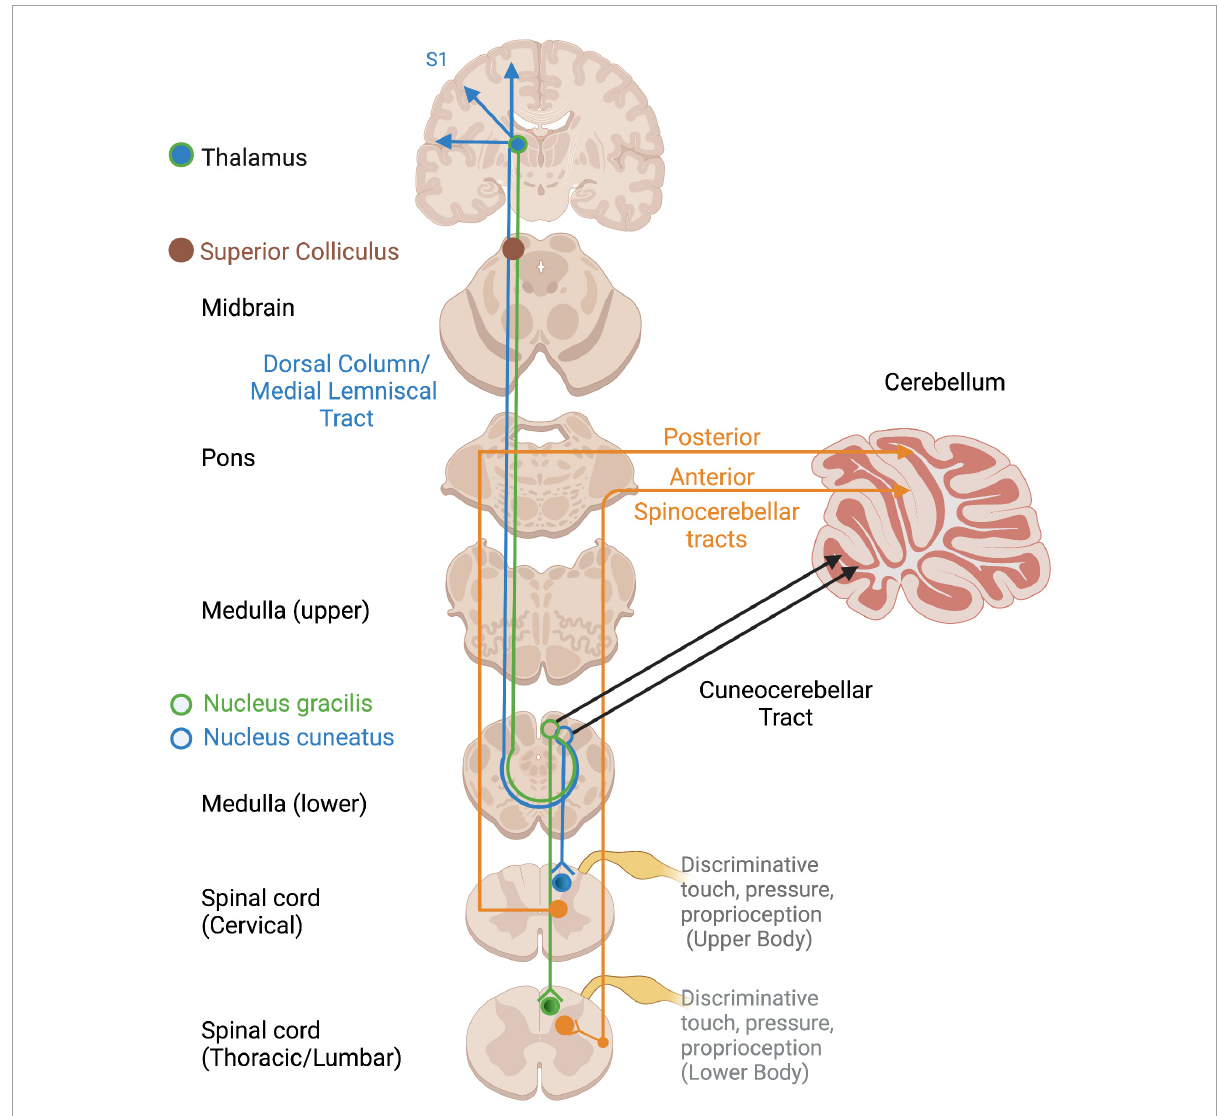
FIGURE2 Ascending cortical and cerebellar somatosensory tracts. Open circles reflect terminations of sensory tracts, after which projections take various pathways. DC/ML, Dorsal column/Medial lemniscus; VPL, ventral posterior lateral nucleus of